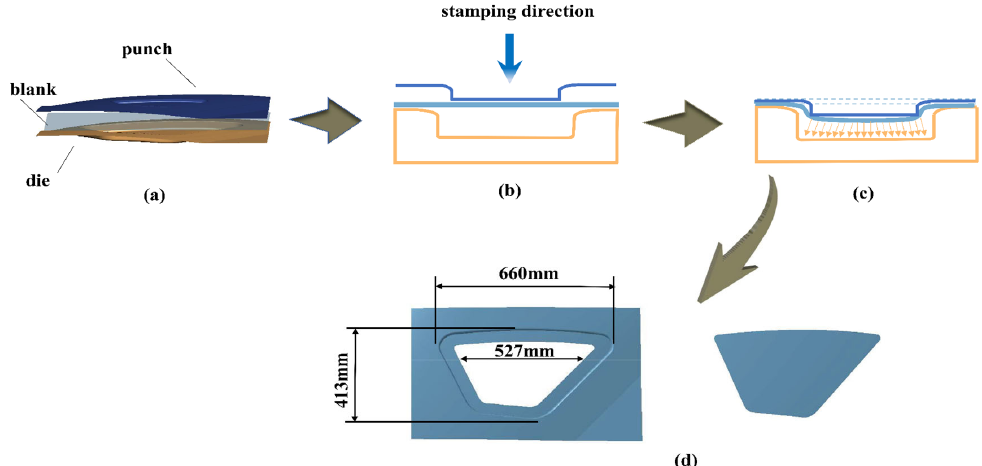
Figure 3. The forming process and geometry of the rail vehicle side window ( a ) Finite element model of the forming process ( b ) Hot stamping process ( c ) Blow forming process ( d ) Part geometry. (2)